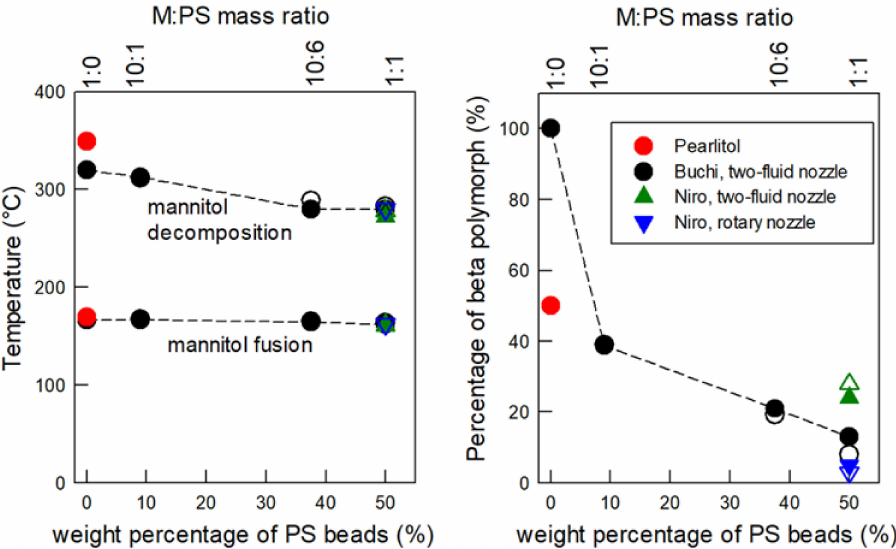
Figure 5. Influence of the M/PS ratio on ( left ) the temperatures of fusion and decomposition of mannitol determined from TGA/DSC curves and ( right ) the percentage of the β polymorph, deter‑ mined from XRD patterns (see Figure 6) for samples prepared with the lab‑scale (Büchi) or the pilot‑ scale (Niro) spray‑driers. The data for the commercial mannitol Pearlitol ® is shown for comparison. Empty symbols correspond to the etched samples. The dashed lines are guides for the